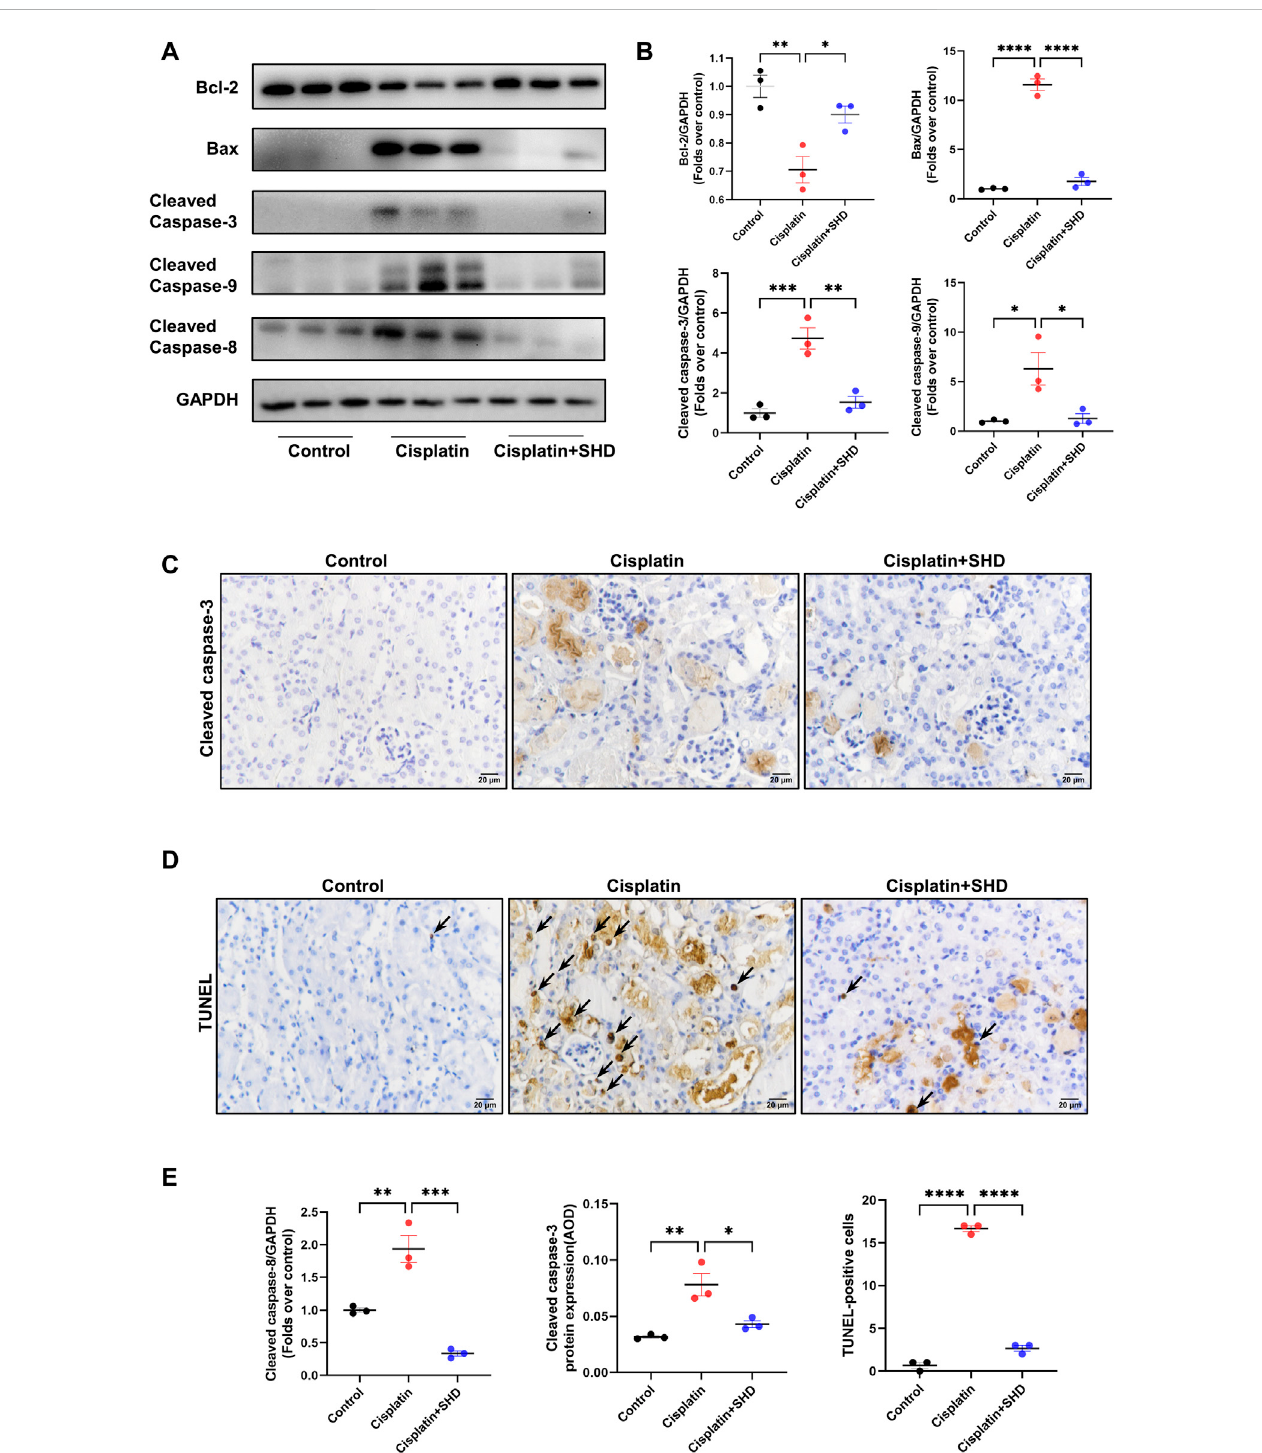
FIGURE 7 Effects of SHD on apoptosis induced by Cisplatin in the kidney. (A) Representative Western blot images of Bcl-2, Bax, Cleaved-Caspase3, Cleaved- Caspase8, and Cleaved-Caspase9 in the kidneys. (B) Densitometric analyses of BCl2, Bax, Cleaved-Caspase8, and Cleaved-Caspase9 proteins expression normalized to GAPDH content ( n = 3). (C) Representative immunohistochemistry (IHC) images of Cleaved-Caspase3 protein in renal cortical glomeruli and tubular epithelium (400 ×). Scalebar =20 μ m. (D) Representative results of TUNEL staining ofthekidney sectionin eachmice group ( n =3).Arrowheads indicate TUNEL-positive cells. Scale bar = 20 μ m. (E) Densitometric analyses of Cleaved-Caspase3 protein expression normalized to GAPDH content ( n = 3). Semiquantitative analysis of IHC for the Cleaved-Caspase3 protein expression. AOD = IOD/area. Semiquantitative analysis of TUNEL-positive cells. Data presented are means ± SEM. p p < 0.5, pp p < 0.01, ppp p < 0.001, pppp p < 0.0001. Original magni fi cation